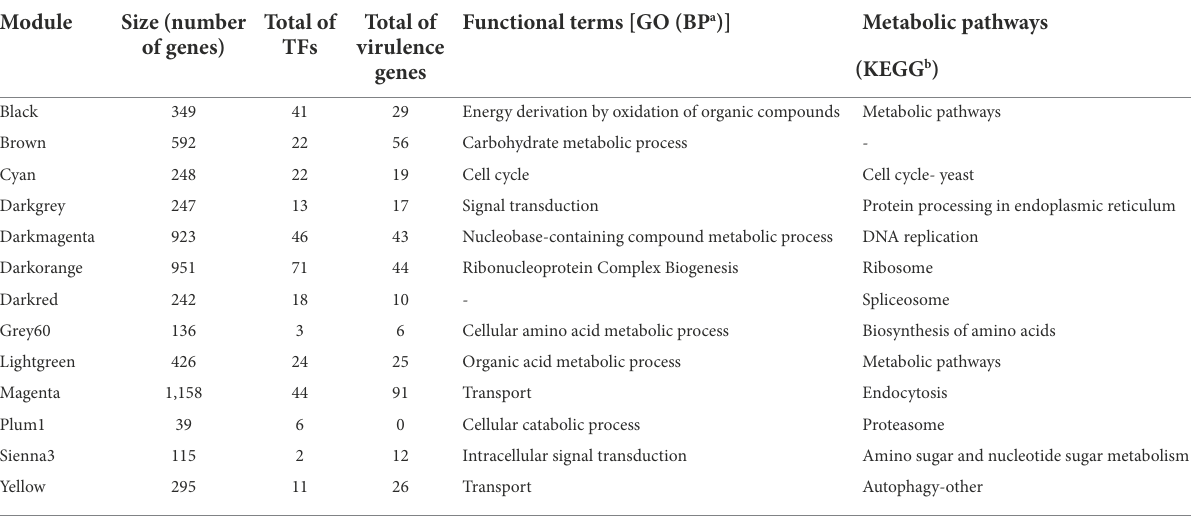
TABLE 1 Co-expression modules of Ustilago maydis